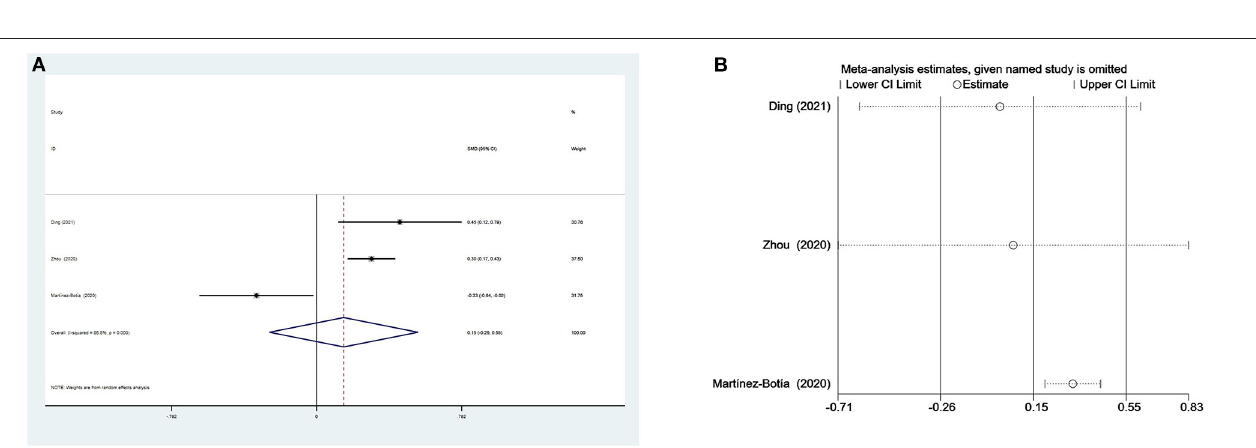
FIGURE 4 | Results of meta-analysis on MLR between depressed patients and controls. (A) Forest plot Forest plot of standardized mean difference in MLR between depressed patients and controls. Depressed patients had slightly higher MLR than controls without a significant difference (SMD = 0.15, 95% CI: − 0.26 to 0.55; p > 0.05). Heterogeneity among three studies remained high ( I 2 = 86.8%, p < 0.001) and the random-effects model was used. (B) Sensitivity analysis suggested that the results of the meta-analysis were unstable.